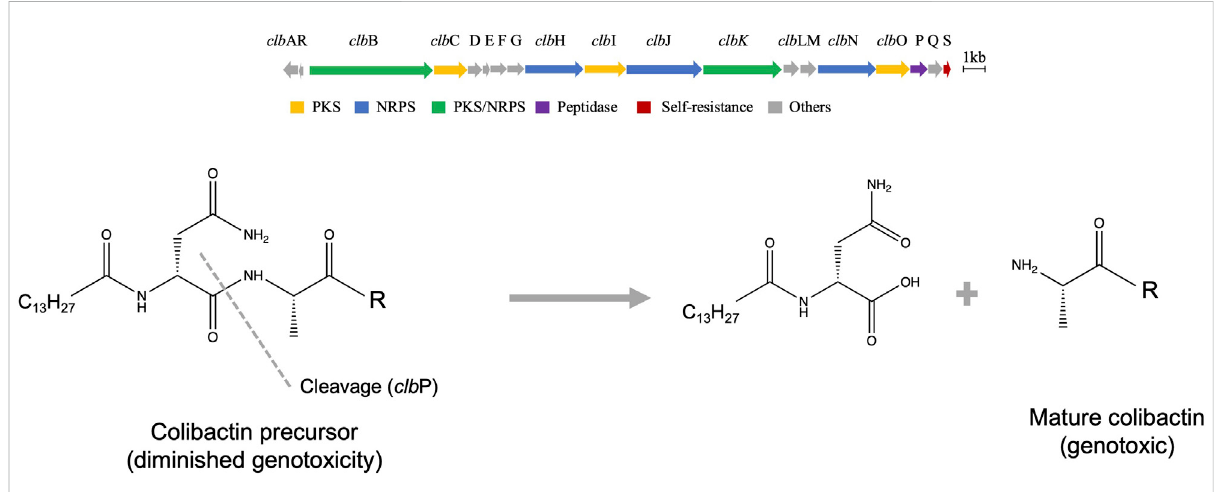
FIGURE 1 Genetic organization and possible biosynthesis of colibactin. (A) Organization of the biosynthetic genes cluster of colibactin. (B) Prodrug activation hypothesis overview shows the last required step for production of the genotoxin, which is catalyzed by peptidase